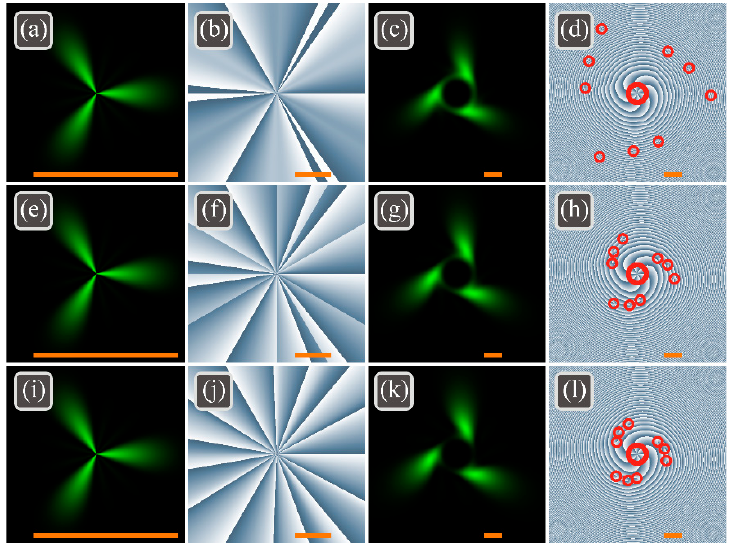
Figure 4. The intensity (columns 1 and 3) and the phase (columns 2 and 4) distributions of the light field (33) with n = 5, k = 2, m = 3, a = 0.8 ( a – d ), a = 1.0 ( e – h ), a = 1.2 ( i – l ), w 0 = 500 µ m in the initial plane z = 0 ( a , b , e , f , i , j ) and in the near field z = z 0 /2 ( c , d , g , h , k , l ). The small thin red circles and one big red circle in phase distributions ( d , h , l ) highlight the 1st-order OVs and the central 6th-order vortex, respectively. The scale mark in each figure corresponds to 1